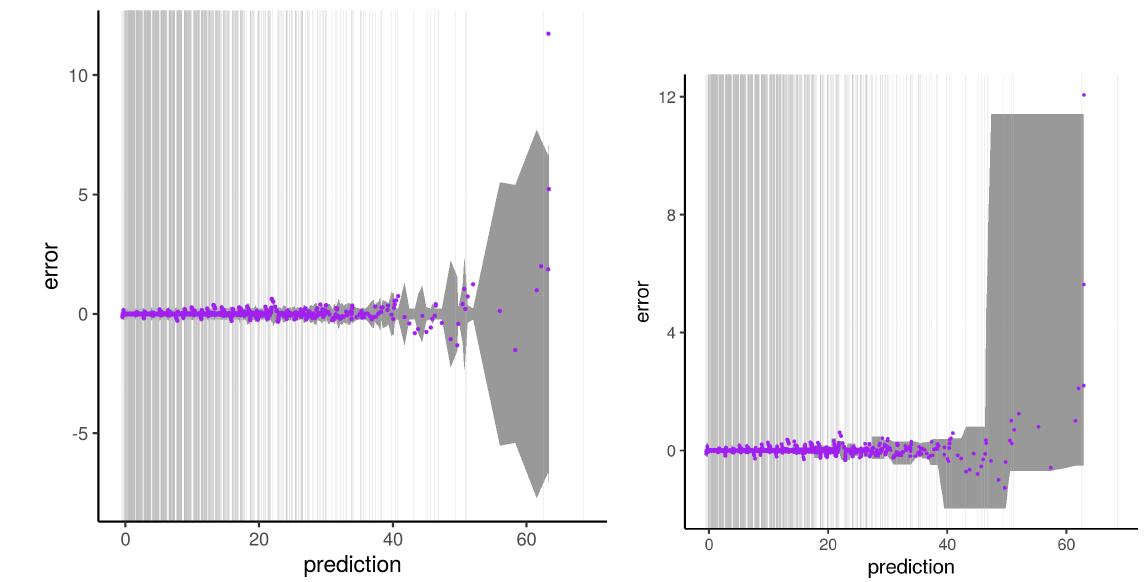
Figure 12. Illustration of the artifact of RFreg on structural modeling error with dataset B and subset type 2. Artifact on the error (purple) and Wager 2014 error prediction CI95 (dark gray) is shown on the left . Artifact on the error (purple) and Lu 2019 error prediction CI95 (dark gray) is shown on the right . Vertical gray lines represent output subset used for the training phase.